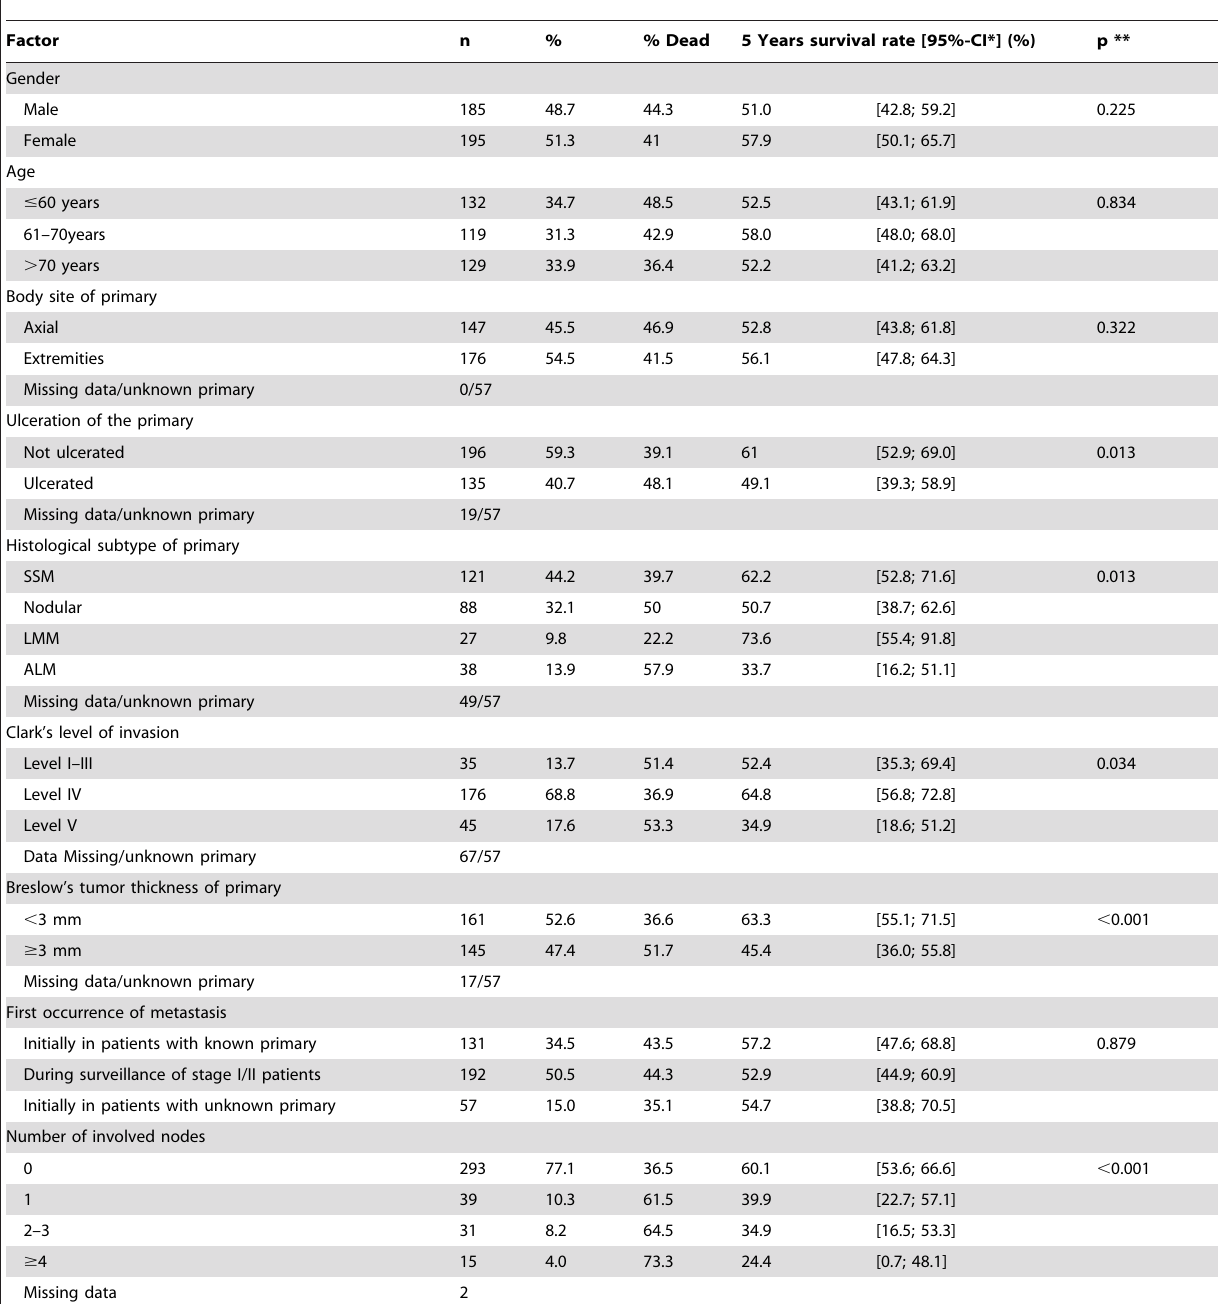
Table 1. Patient characteristics and survival analysis according to